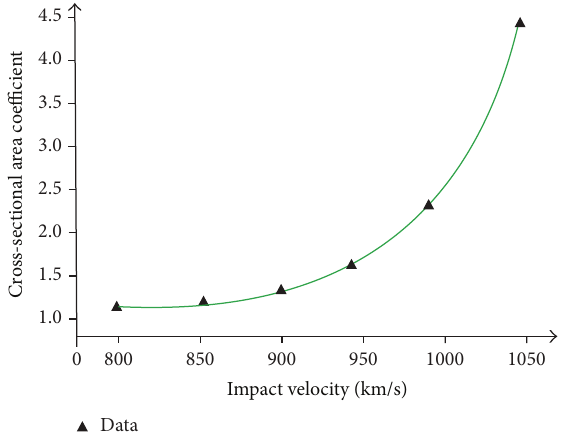
Figure 10: The relationship between 𝐾 𝑠 and impact